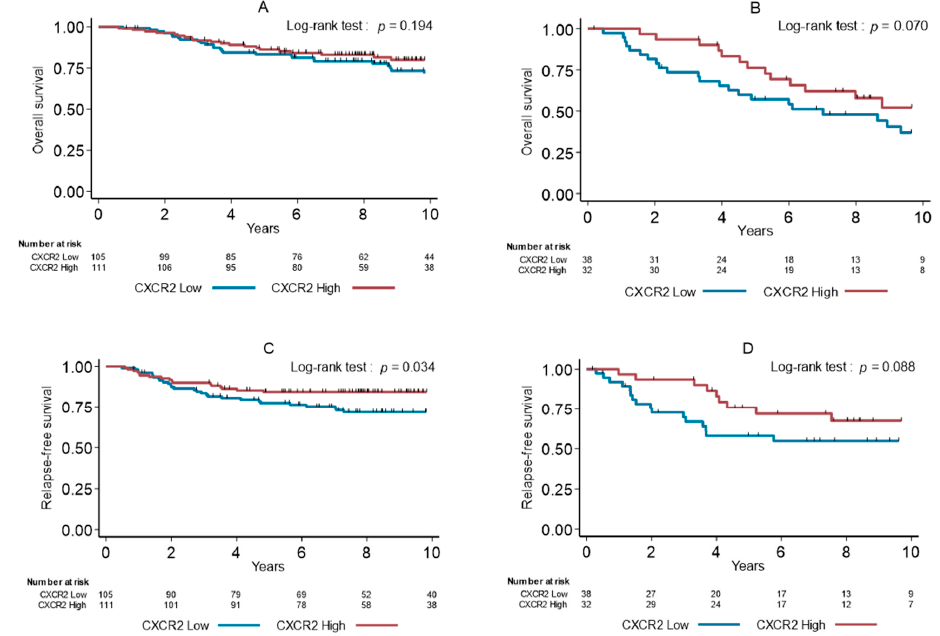
Figure 3. Overall survival ( A , B ) and relapse-free survival ( C , D ) in function of the CXCR2+ cell density (median value used as cutoff) in patients with TNBCs treated ( A , B ) or untreated ( C , D ) with adjuvant chemotherapy.